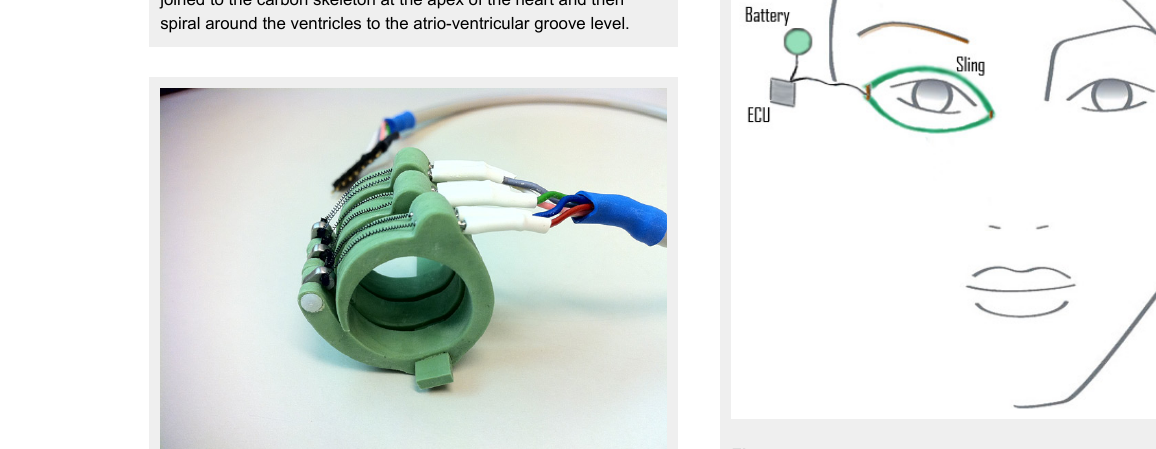
The external bi-ventricular assist device comprises a skeleton of carbon fibre (black bands) and a mesh (yellow) of aramidic fibres. The carbon fibre follows the interventricular septum, the atrio- ventricular groove, and encircles the cardiac apex. Zig-zagging through the aramidic tissue are interwoven nitinol fibres, which are joined to the carbon skeleton at the apex of the heart and then spiral around the ventricles to the atrio-ventricular groove level.